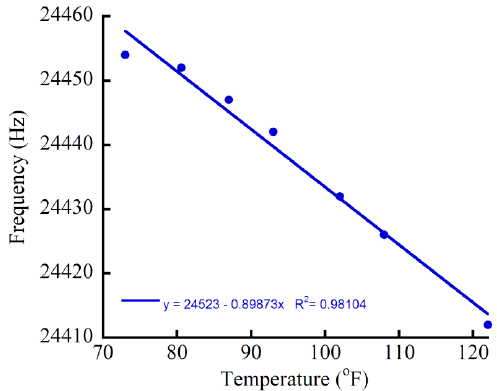
Figure 7. Effect of temperature on the resonant frequency of the sensor. When the monolithically-integrated μGC column is heated, conductive heat transfer through the silicon heats the sensors, shifting the resonance